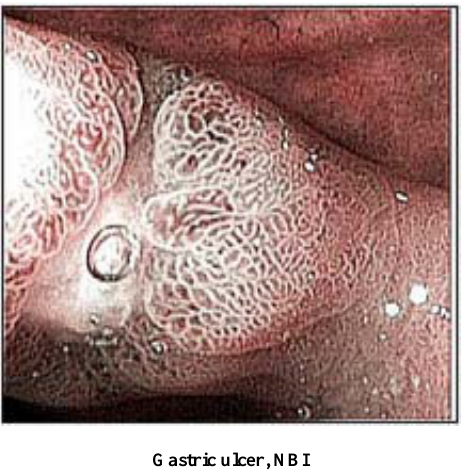
FIGURE 12. Stomach: gastric benign ulcer in the antral mucosa; narrow-band imaging at low magnification. The architecture of the antral mucosa is well contrasted